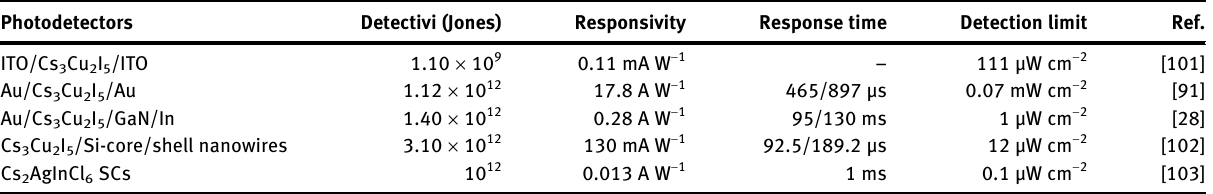
Table  : Summary of the key device parameters of some reported lead-free perovskite UV photodetectors. Photodetectors